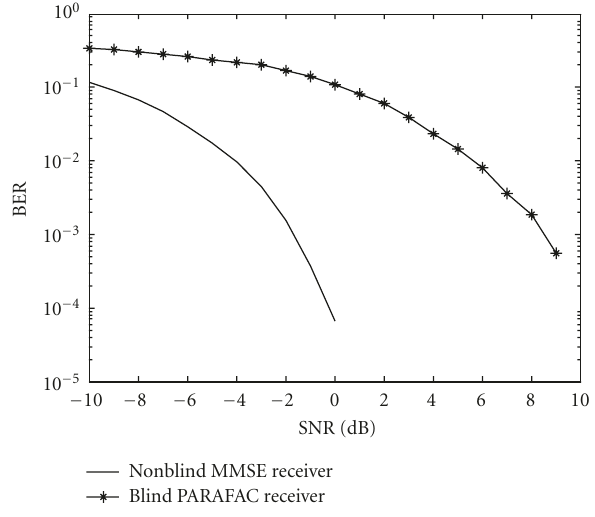
Figure 7: The algorithm performances comparison with N = 20.